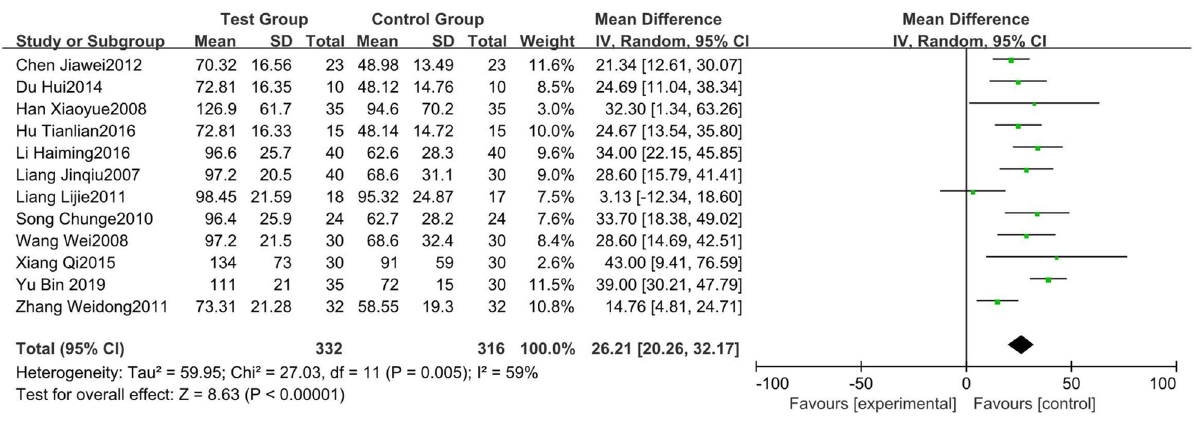
Fig 4. Forest plot of changes in number of platelets.